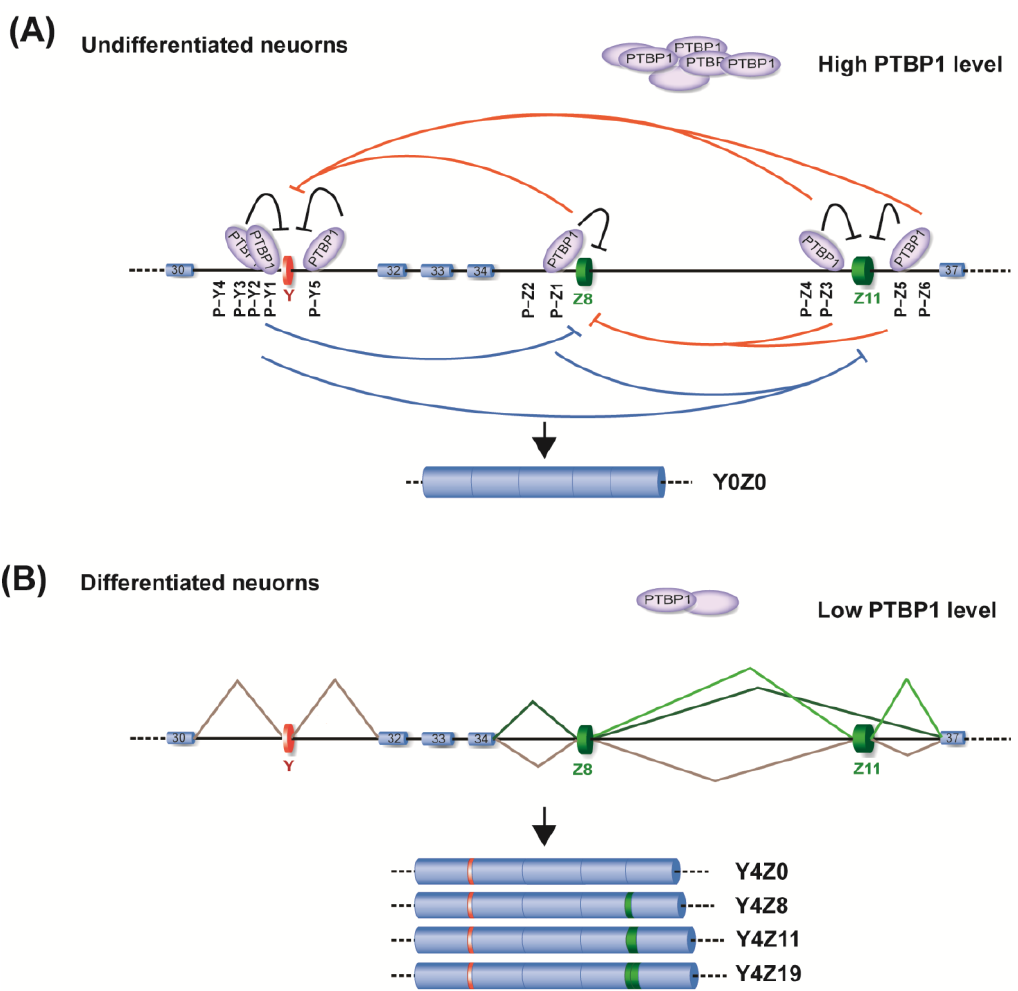
Figure 6. A model for the PTBP1–RNA interaction network that represses the coordinated splicing of AGRN Y and Z exons . ( A ) PTBP1 proteins interact with multiple binding sites around Y and Z exons. Each site mediates the repressive activity of PTBP1 against a proximal exon (black lines) as well as distal exons (PTBP1 − dependent repression of upstream and downstream exons from distal cis − elements is indicated by blue and orange lines, respectively). Multiple bindings of PTBP1 around these exons form a complex network to repress the coordinated splicing of Y and Z exons in a redundant and compensatory manner. ( B ) In differentiated neurons PTBP1 is downregulated, which enhances splicing of Y and Z exons to generate neuronal isoforms of agrin in cooperation with other splicing factors.